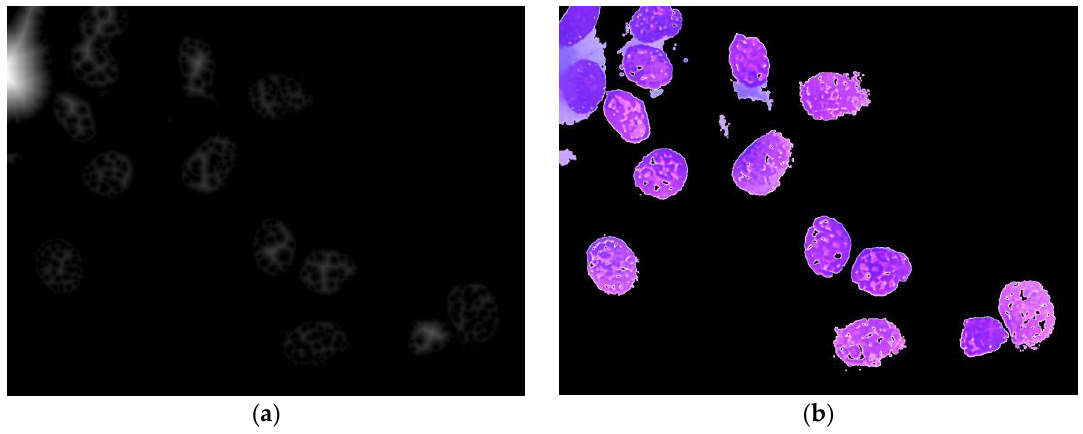
Figure 8. Output images of Euclidean Distance Transform ( a ) and Watershed detected cells ( b ).